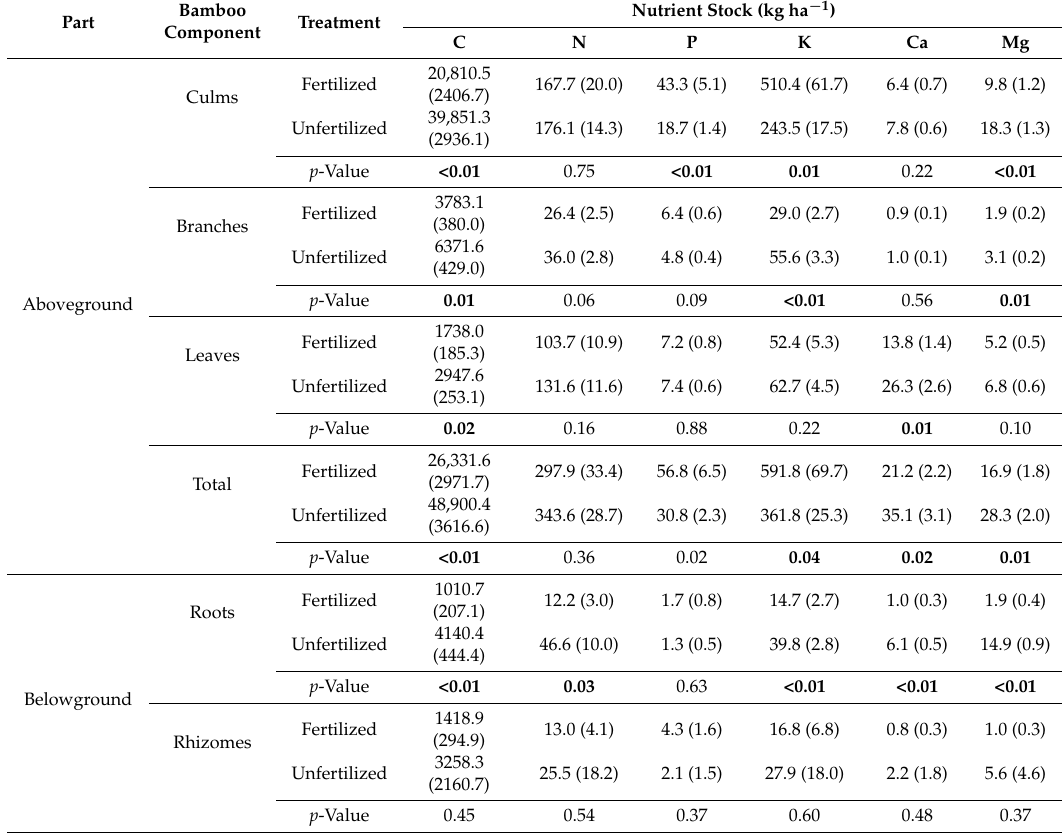
Table 4. Nutrient stocks of bamboo components in a Moso bamboo stand ( n =